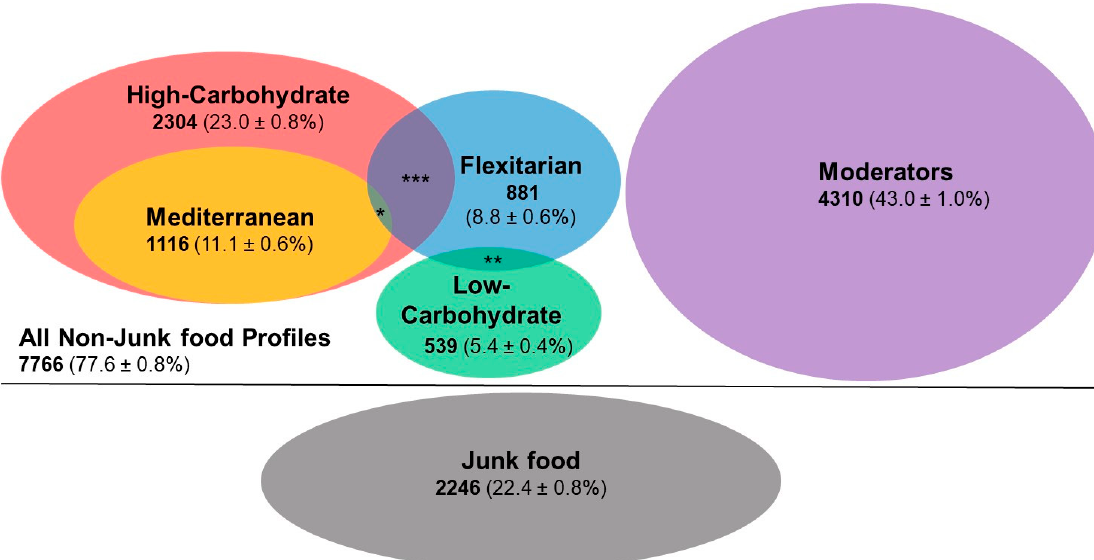
Figure 2. Nutrition profiles derived from the Sovereign Wellbeing Index, 2014. Total sample N = 10,012; totals are given for each profile group with % ± 95% confidence limits in brackets; Crossovers percent are percentage of total sample: * High Carb, Mediterranean & Flexitarian 23 (0.2 ± 0.1%); ** Flexitarian & Low Carb 52 (0.5 ± 0.1%); *** High Carb & Flexitarian 216 (2.2 ±